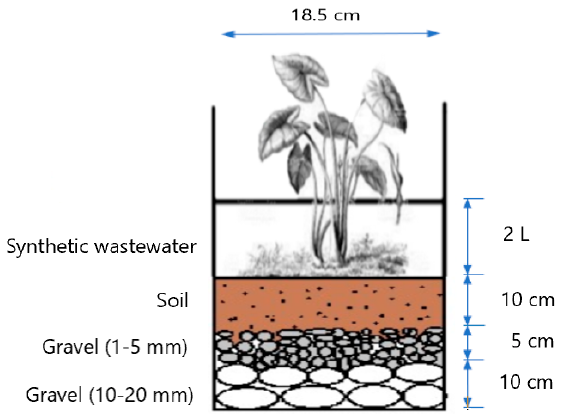
Figure 1. Experimental set up for a constructed wetland (CW) microcosm.